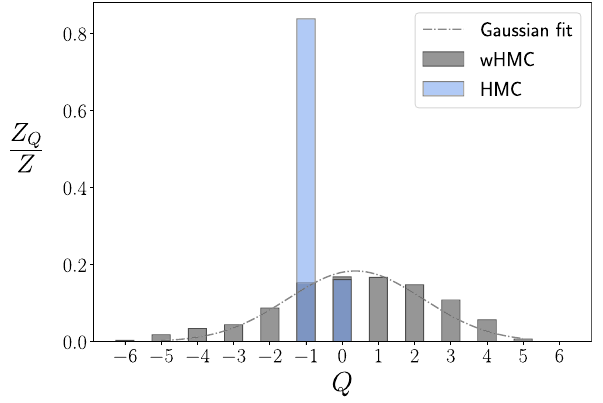
Fig. 14 Z Q / Z versus Q at β = 9 . 0 for HMC and wHMC with N f = 2. A Gaussian fit to the wHMC distribution is also shown